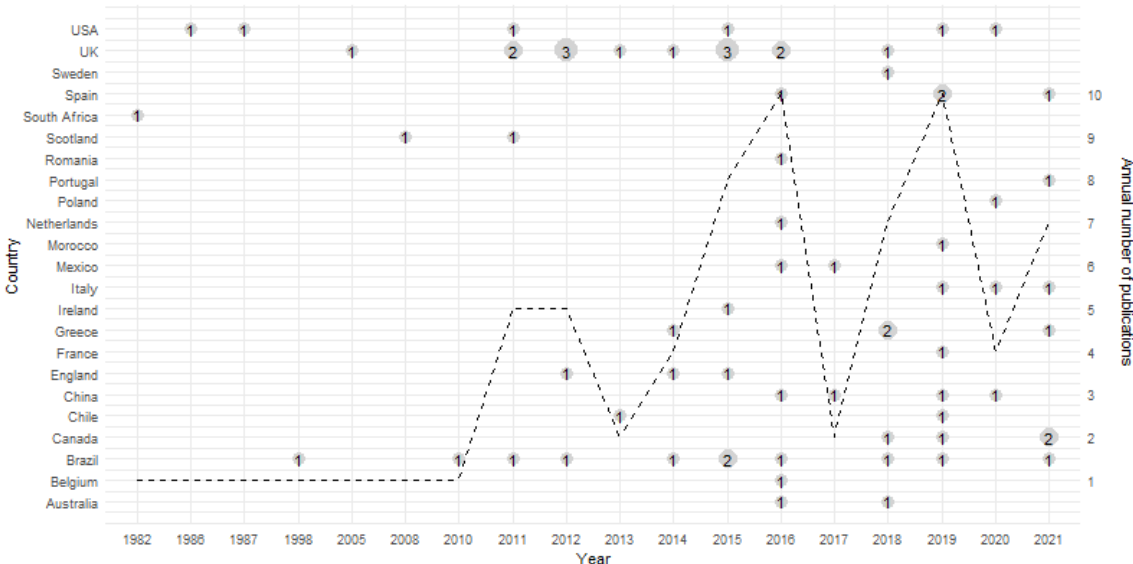
Figure 3. Distribution of studies on DHWC in social housing per country over the years (points) and total number of publications per year (dashed line). The numbers 1, 2 and 3 indicate how many pub-lications each country has per year.